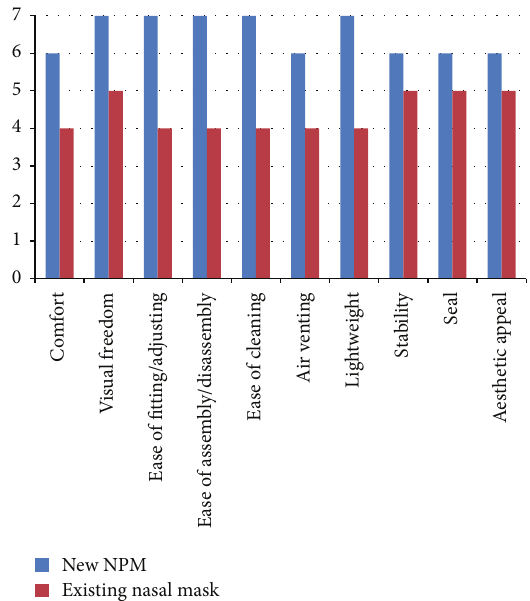
Figure 2: Median scores of participants asked to rate the new NPM compared with their current nasal mask (Group 3). Participants were asked to rate each aspect of the mask using a 7-point Likert Scale where 1 means poor performance and 7 means excellent